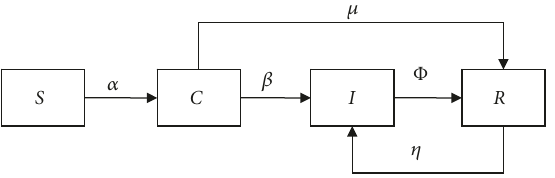
Figure 2: Investor risk contagion mechanism in the stock market.